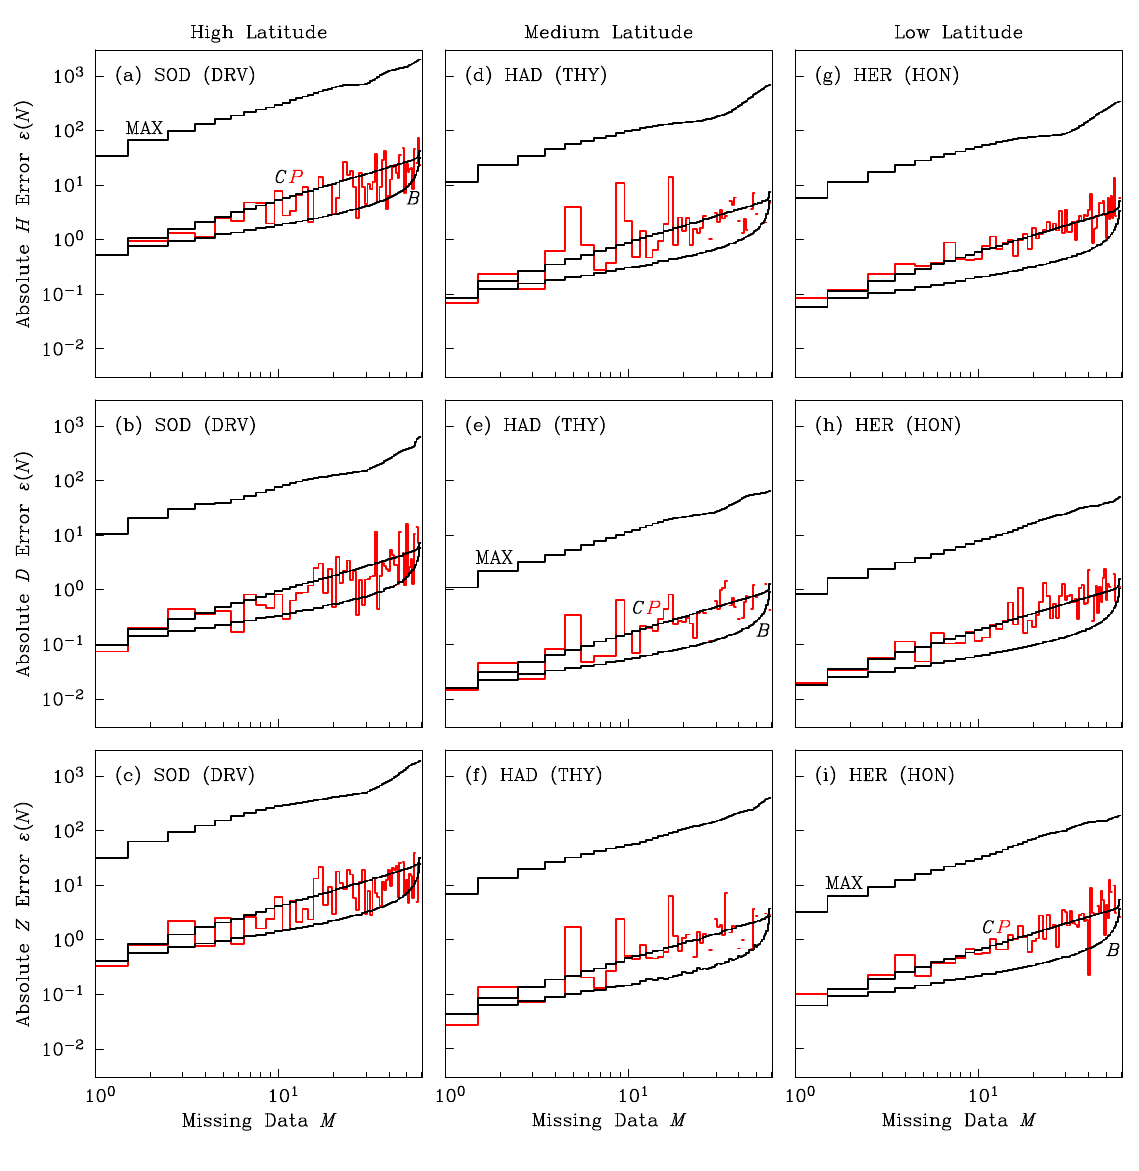
Fig. 4. Root-mean-square RMS and maximum MAX absolute error results (cid:15)(N) for (a–c) H , D , and Z magnetic-vector components for high-latitude observatories SOD (DRV), (d–f) medium-latitude observatories HAD (THY), (g–i) low-latitude observatories HER (HON), each as a function of number of missing data M . (B,C,P) denotes results for (binomial, continuous, proxy) gap distributions. No proxy result is calculated when 3 or fewer proxy instances are